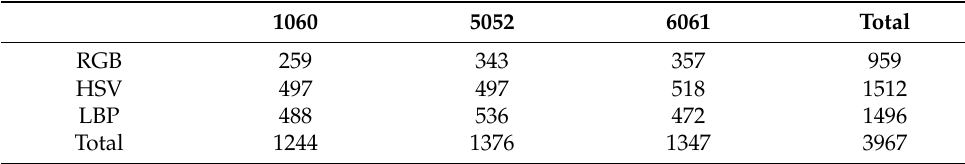
Table 1. Sample size in the database for different grades.